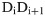
Lengths of the paths are different for different expansions.(a) Expand on L-edge
DiDi+1. (b) Expand on L-edge
Di+1Di+2. (c) Expand on E-edge
P1Di+1 (the number represents the length of the edge, triangles represent p-nodes, hollow circles represent d-nodes to be filled, and solid circles represent filled nodes).